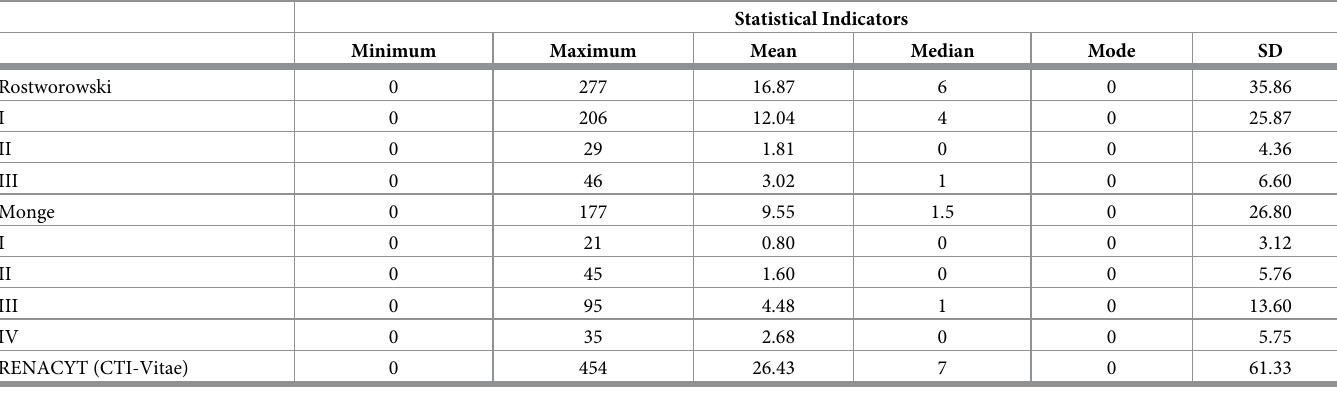
Table 2. Number of RENACYT researchers from Peruvian universities and licensed graduate